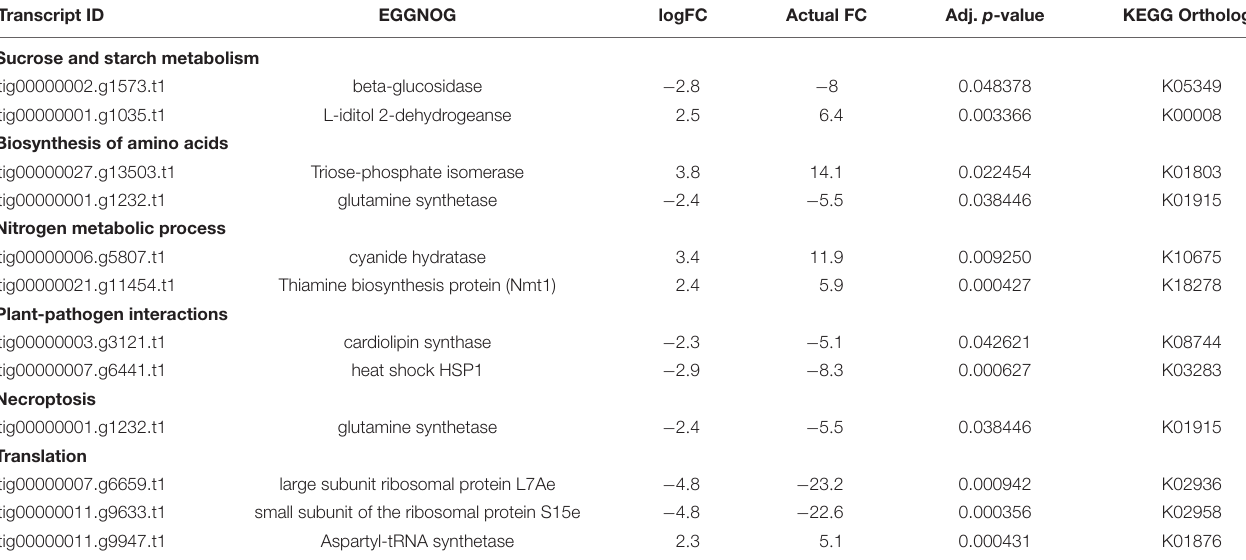
TABLE 3 | Significant DE genes under various metabolic pathways for pathogen comparison 4 ( Figure 1 ): CCTDscr vs.